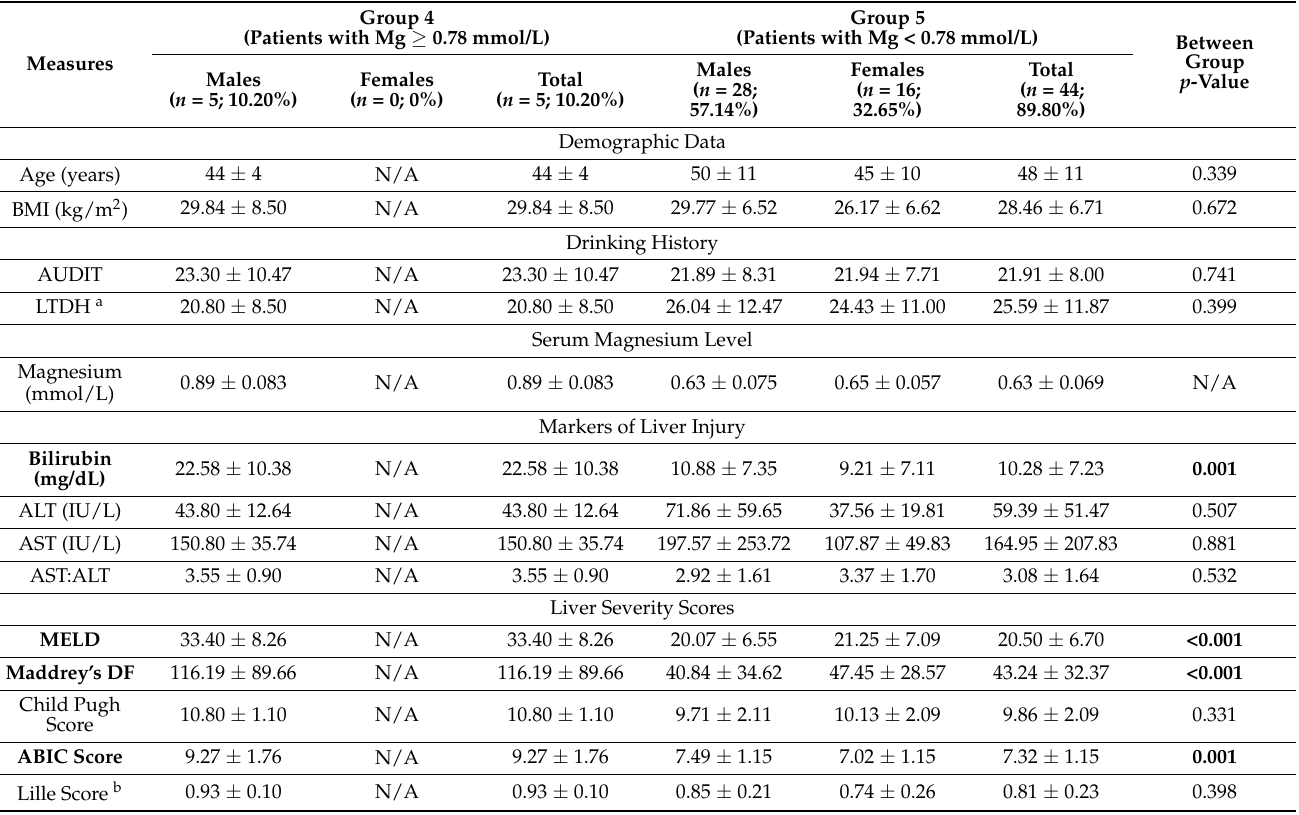
Table 2. Demographic, drinking, liver injury and severity markers in AH patients grouped by magnesium level at a cutoff of 0.078 mmol/L. Statistical significance was set at p < 0.05. Significant measures are in bold. Data are presented as the mean ± standard deviation. Group 4 Group 5 (Patients with Mg ≥ 0.78 mmol/L) (Patients with Mg < 0.78 mmol/L) Between Group Males Females Total Females Total p -ValueMales ( n = 28; ( n = 16; ( n = 44; ( n = 5; 10.20%) ( n = 0; 0%) ( n = 5; 10.20%) 57.14%) 32.65%)